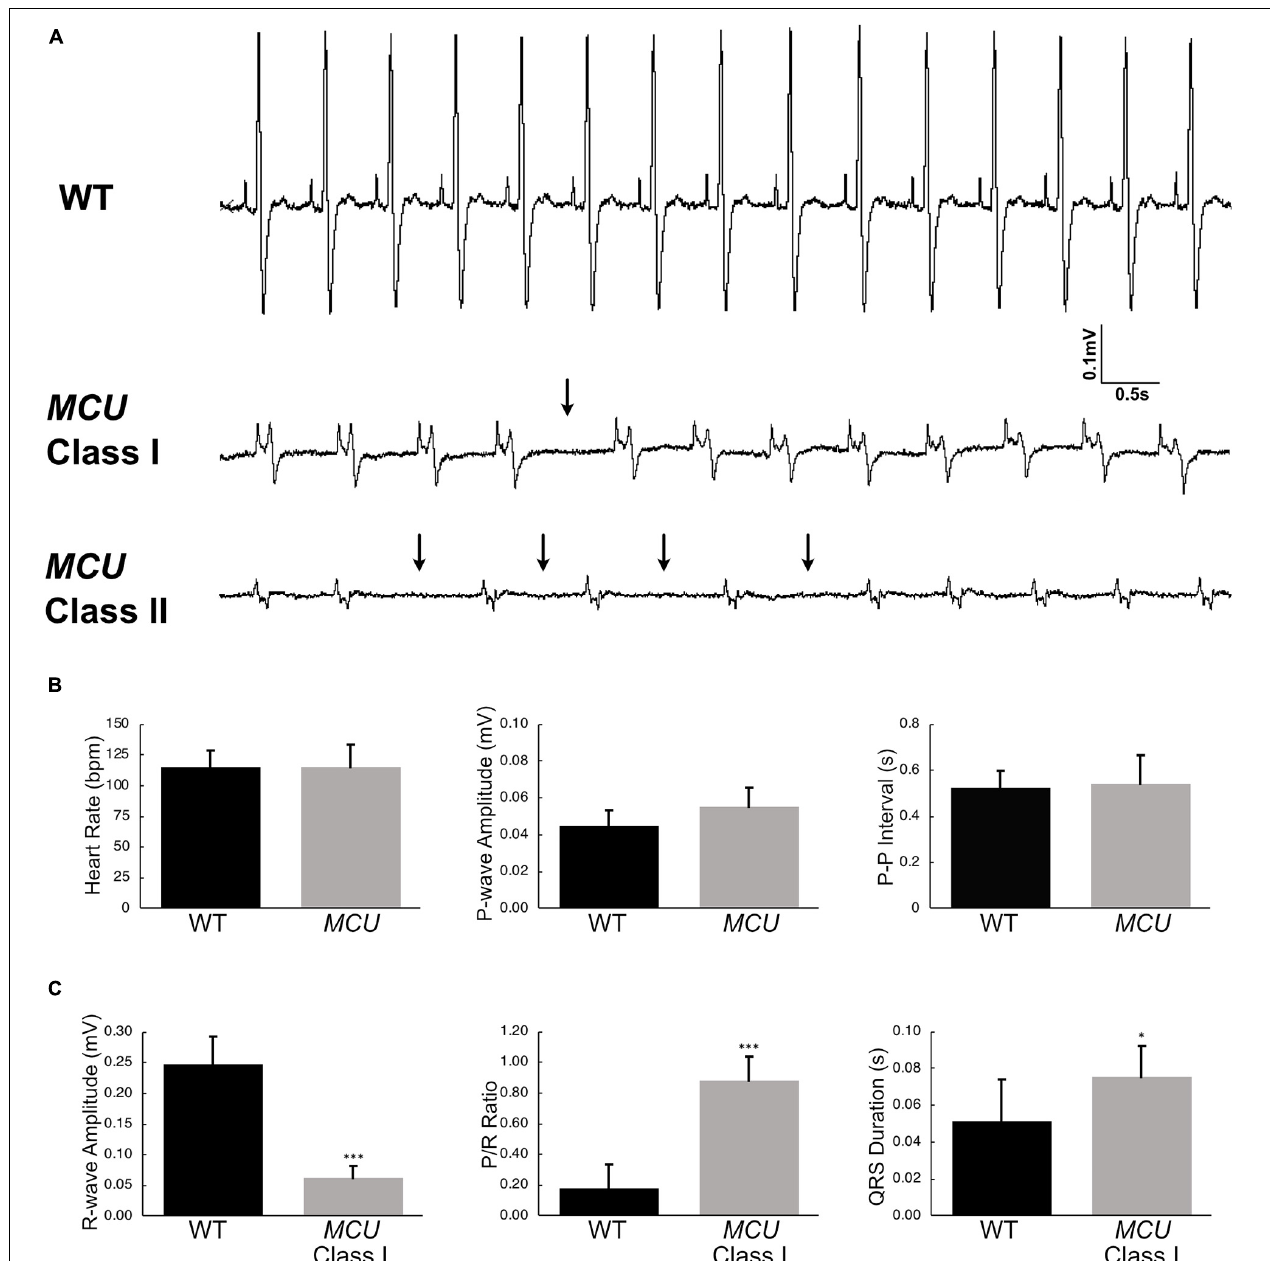
FIGURE 4 | Electrocardiogram analysis of wildtype and MCU mutant fish. (A) ECG tracings of wildtype fish (top), Class I MCU mutant (clearly distinguishable QRS complex, middle) and Class II MCU mutant (highly abnormal QRS complex, bottom) highlight episodes of long beat-to-beat pauses. Arrows point to beat intervals that are greater than mean + 2 σ . (B) Analysis and comparison of ECG indices between wildtype and MCU mutants (Class I and II combined). No significant differences were identified in heart rate (115.4 bpm v 115.0 bpm, p > 0.05), P -amplitude (0.045 mV v 0.055 mV, p > 0.05), and P - P interval (0.524 s v 0.539 s, p > 0.05) between wildtype and mutant, respectively. (C) Statistical differences were present in R -wave amplitudes (reduced in MCU Class I mutant, 0.248 mV v 0.062 mV, p < 0.0001), R -wave amplitude-to- P -wave amplitude ratio (increased in MCU Class I mutant, 0.182 v 0.884, p < 0.001), and duration of the QRS complex (prolonged in MCU Class I mutant, 0.0512 s v 0.0721 s, p < 0.05). * p < 0.05; *** p <